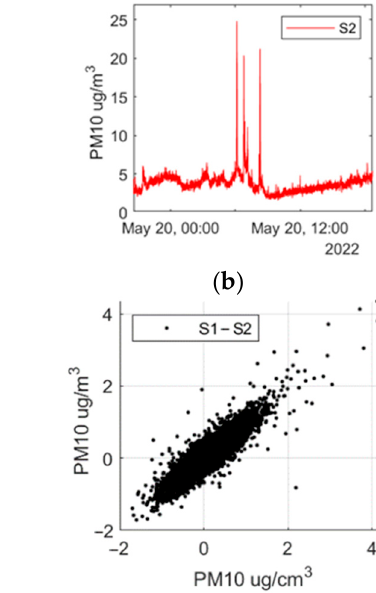
Figure 1. Comparative measurement between two SPS30 sensors: ( a ) Sensor 1 (S1); ( b ) Sensor 2 (S2); ( c ) Difference between Sensor 1 and Sensor 2 (S1–S2); ( d ) scatter plot of the difference between Sen- sor 1 and Sensor 2 (S1–S2).